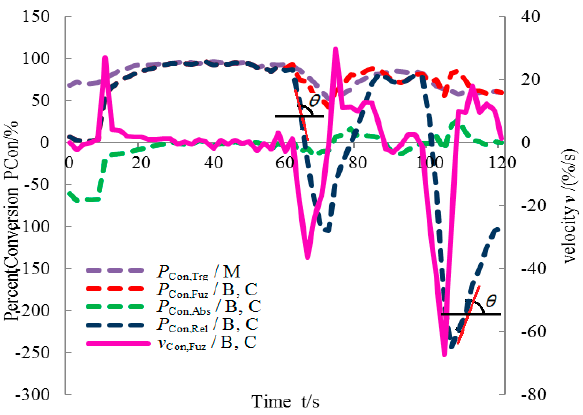
Figure 6. The conversion efficiency tangents.